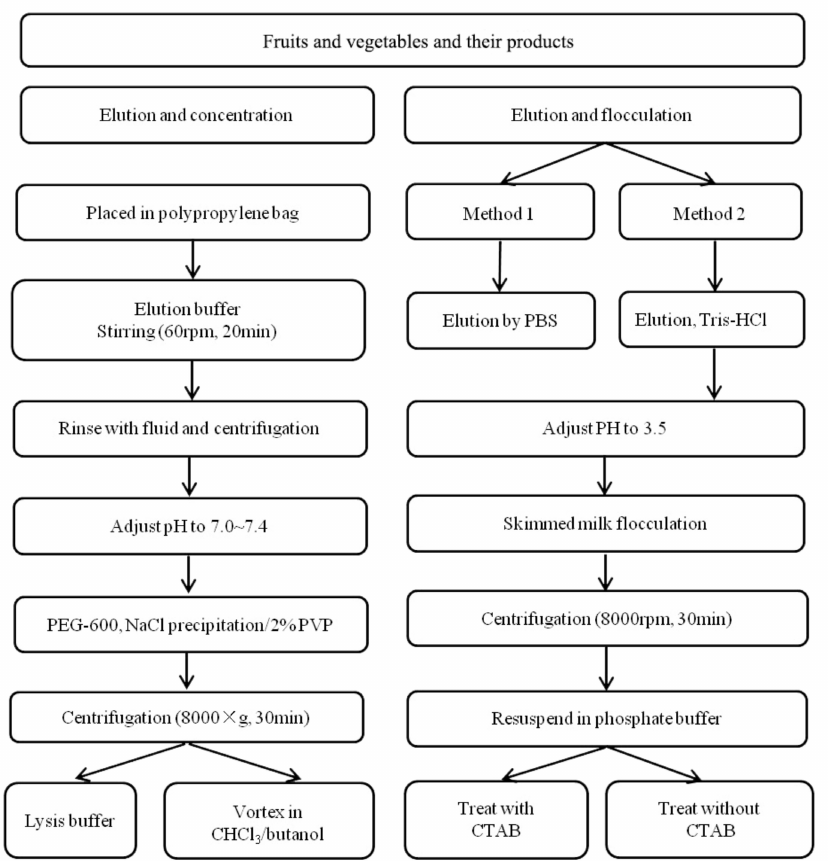
Figure 5. Summary of pretreatment methods for nucleic acid determination of fruits, vegetables, and their products